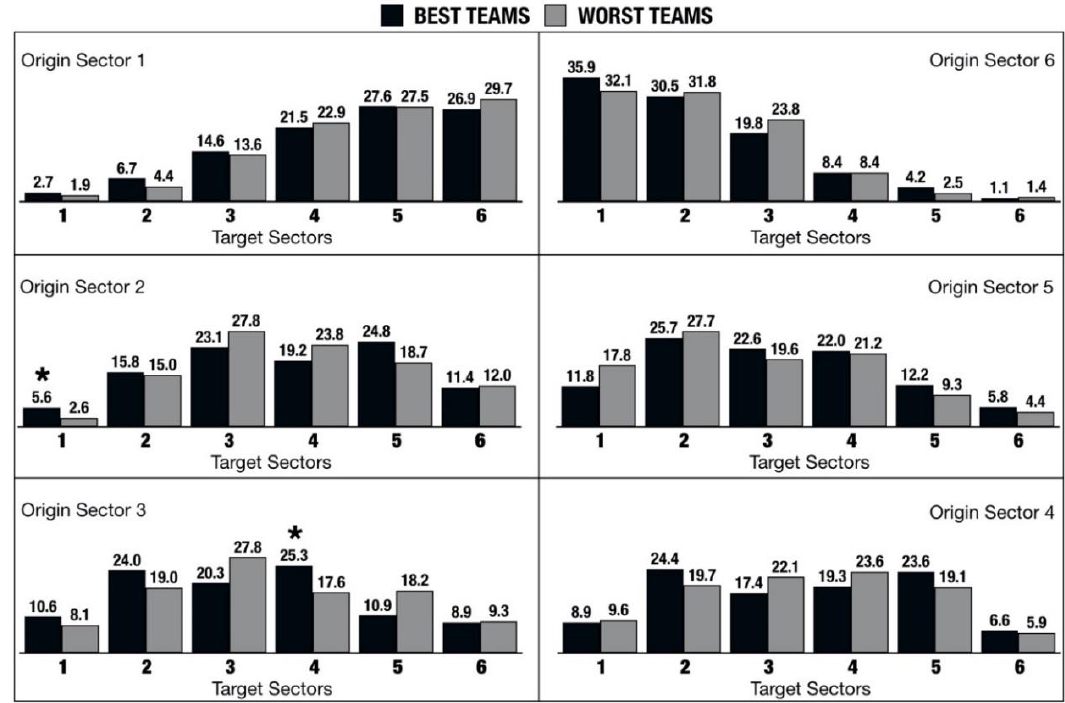
Figure 4. Comparison of mean percentage of throws for best teams vs. worst teams. * p < .05; ** p < .01 *** p<.001. Note: in some cases, not exactly 100% due to